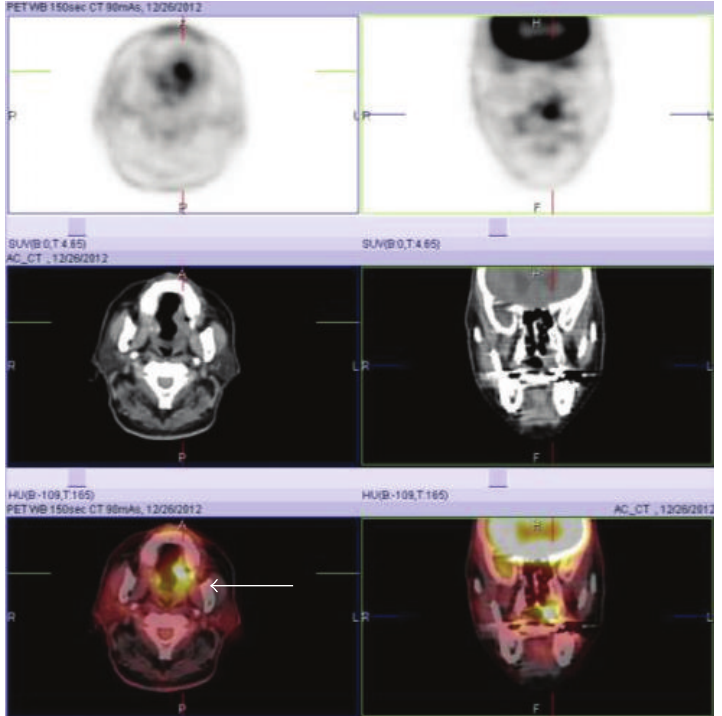
Figure 4: PET-CT image showing abnormal uptake of FDG (SUVmax = 5.2) in the left hard